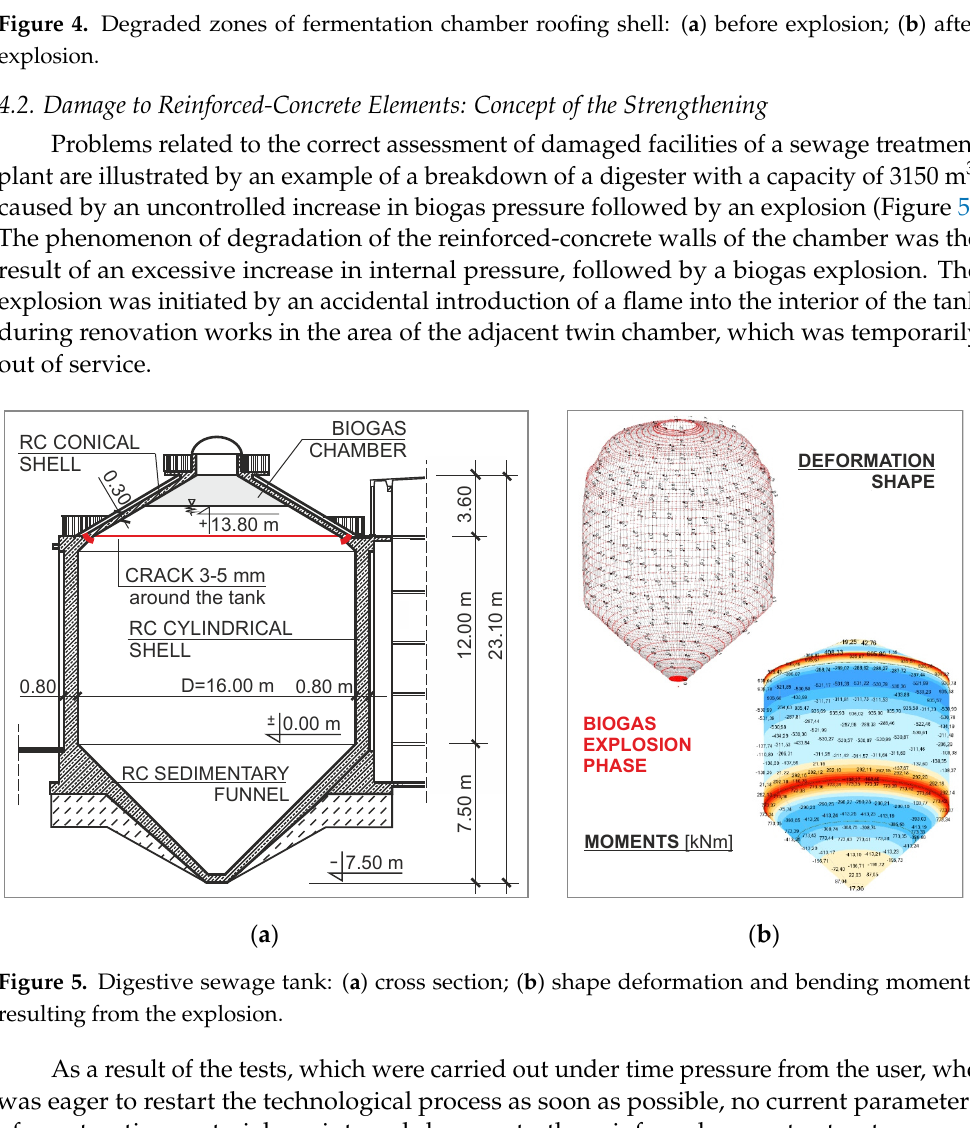
Figure 5. Digestive sewage tank: ( a ) cross section; ( b ) shape deformation and bending moments resulting from the explosion.